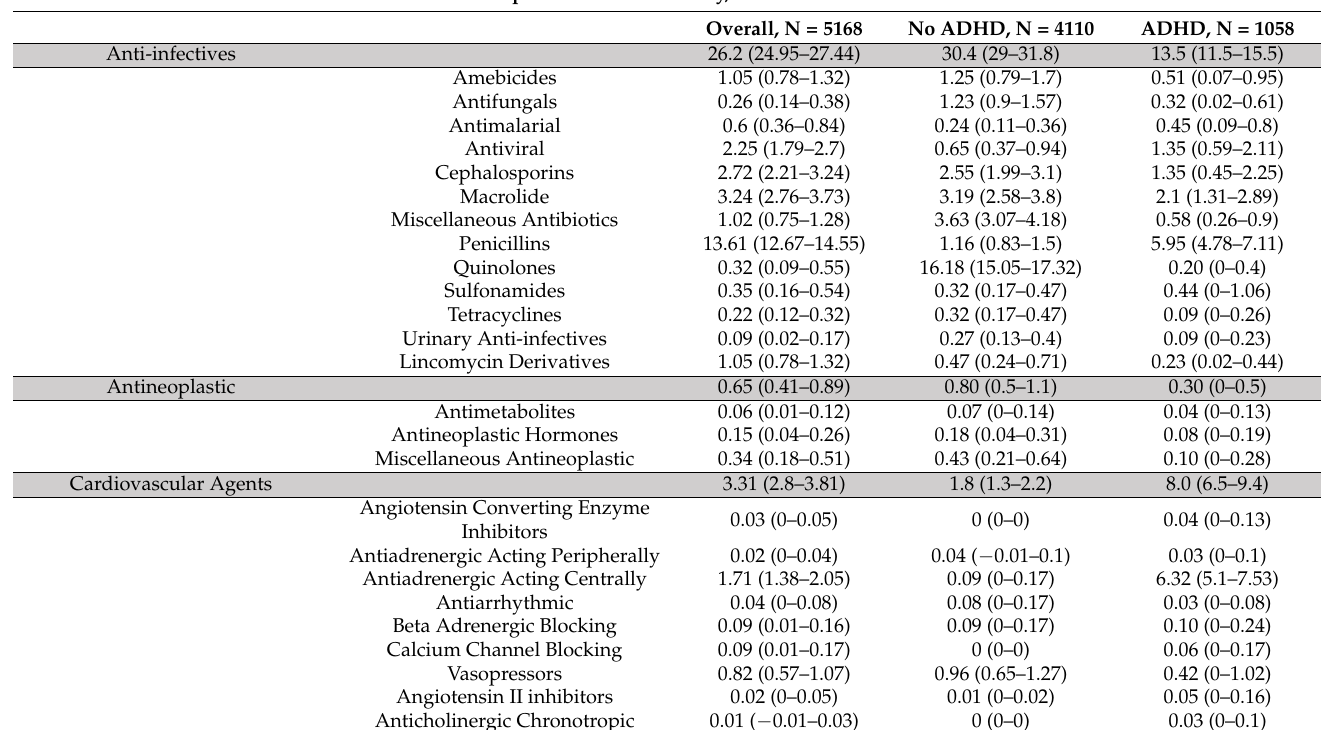
Table 2. Weighted prevalence in the annual use of prescription medications by therapeutic drug class among children and adolescents, overall and by ADHD